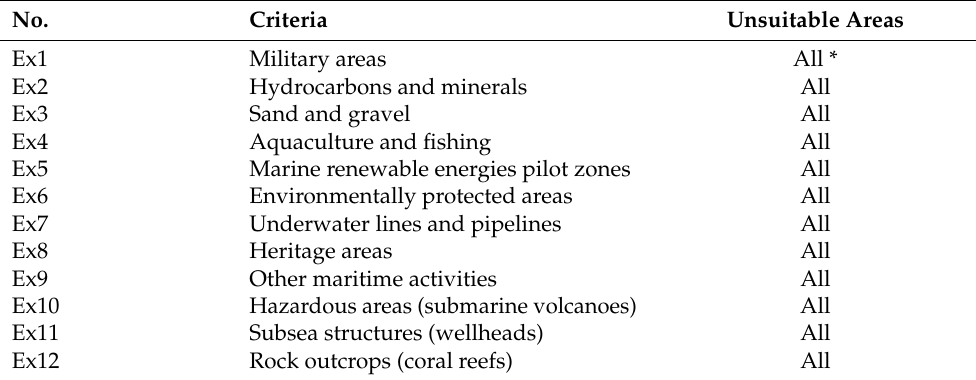
Table 1. Exclusion factors for the export cable routing design [17]. No.